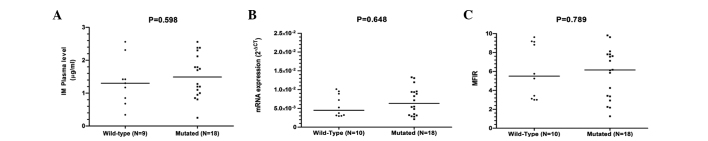
(A) IM plasma levels, (B) ATP-binding cassette subfamily B member 1 mRNA expression and (C) P-glycoprotein expression between the wild-type and mutated groups. The medians were compared using the Mann-Whitney U test. The haplotype groups were as follows: Wild-type, 1236CC/3435CC/2677GG; and mutated, 1236CT/3435CT/2677GT and 1236TT/3435TT/2677TT. IM, imatinib mesylate; MFIR, mean fluorescence intensity ratio.